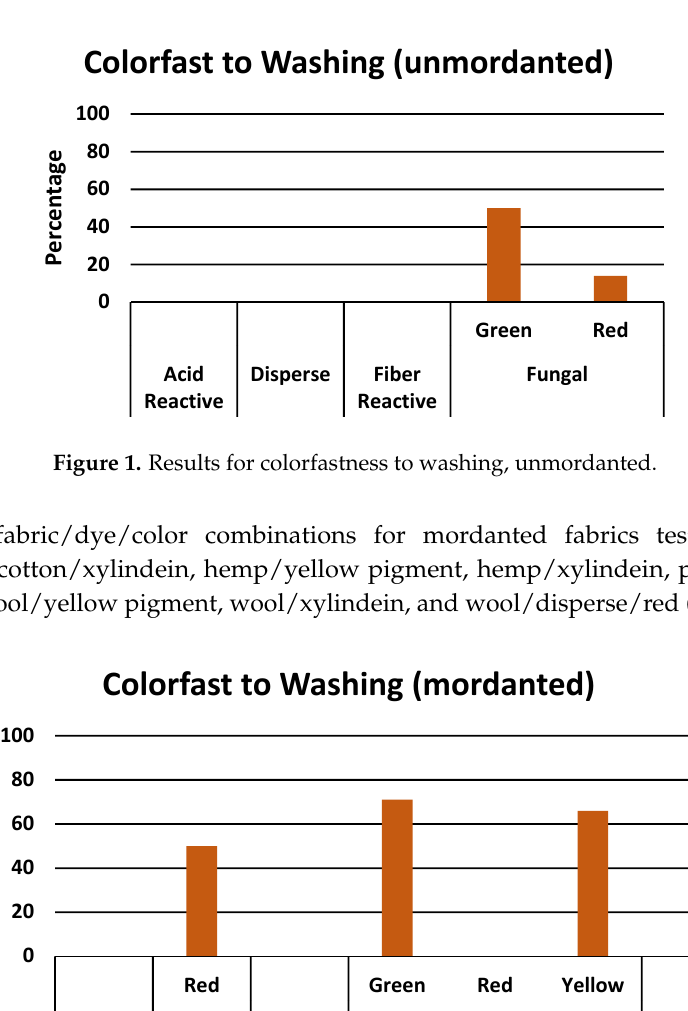
Figure 3. Results for colorfastness to dry crocking, unmordanted.